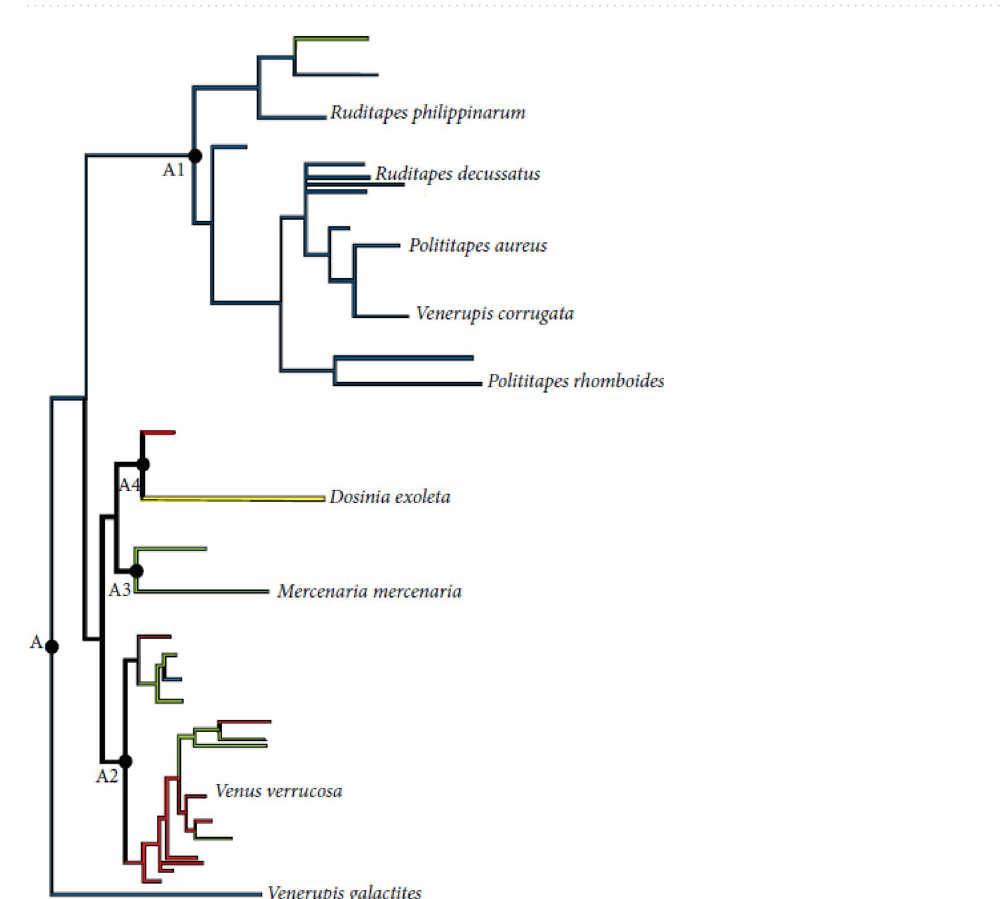
Figure 1. Georeferenced records of Venerupis corrugata , Ruditapes decussatus and Ruditapes philippinarum from 1800 to 2021. Source: GBIF.es.